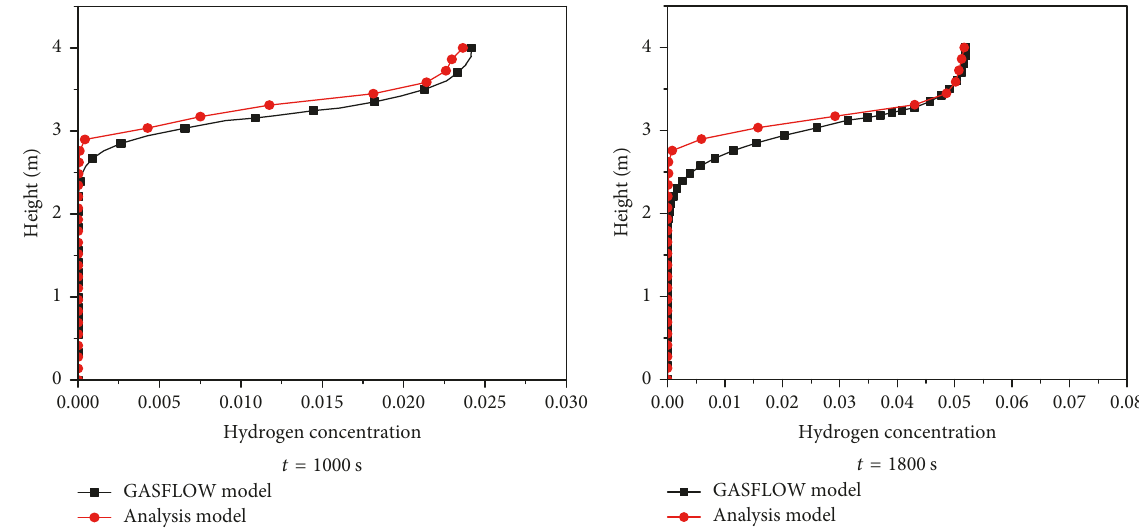
Figure 3: Hydrogen concentration distribution in non-source term compartment.